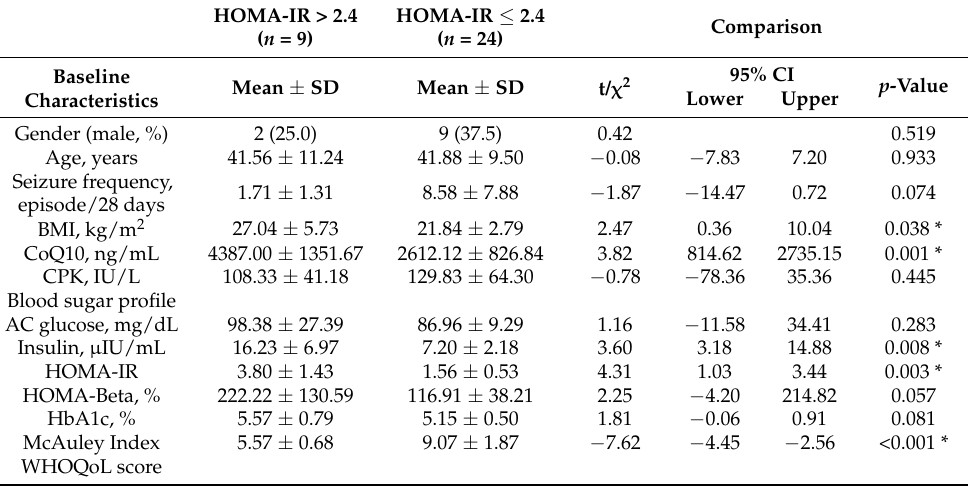
Table 3. Demographic characteristics of AED-resistant epilepsy patients subgrouped by